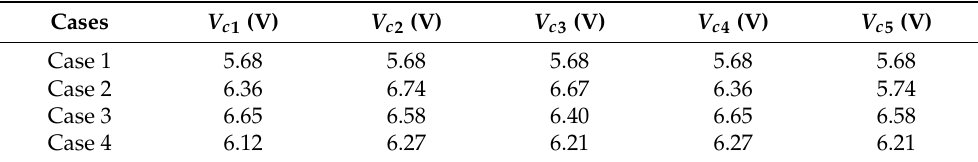
Figure 12. Energy loss in a day under mismatch Case 2 in Figure 9 for a conventional DCR in Figure 5a and the introduced ADCR architectures in Figure 7. Table 2. PV panel voltages under mismatch cases given in Figure 9 for the introduced ADCR DPP voltage equalizer architecture.